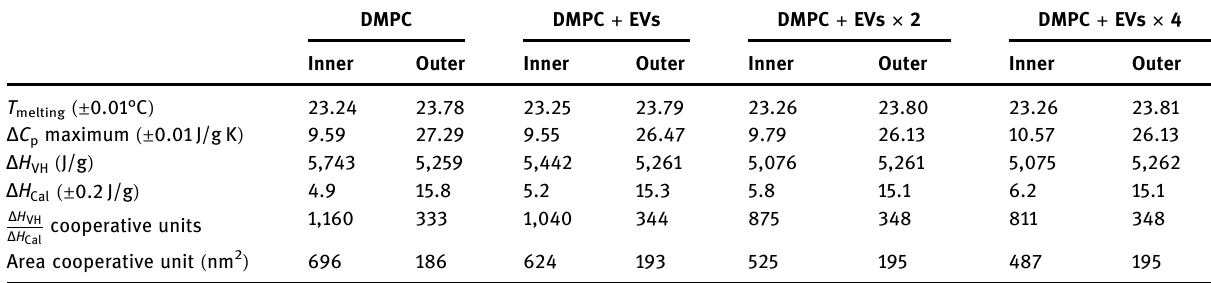
Table 1: Thermodynamic parameters obtained for the two LUVs lea fl ets at varying EVs content DMPC DMPC + EVs DMPC + EVs × 2 Inner Outer Inner Outer Inner Outer Inner Outer T (± 0.01°C ) melting H Δ VH ( J/g )